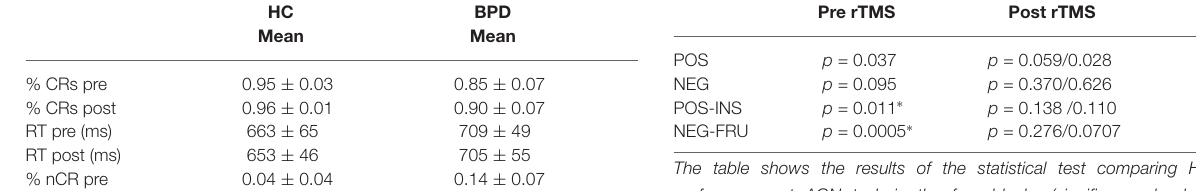
TABLE 4 | Statistical assessment of comparison of HC and BPD pre and post rTMS in AGN task. Pre rTMS Post